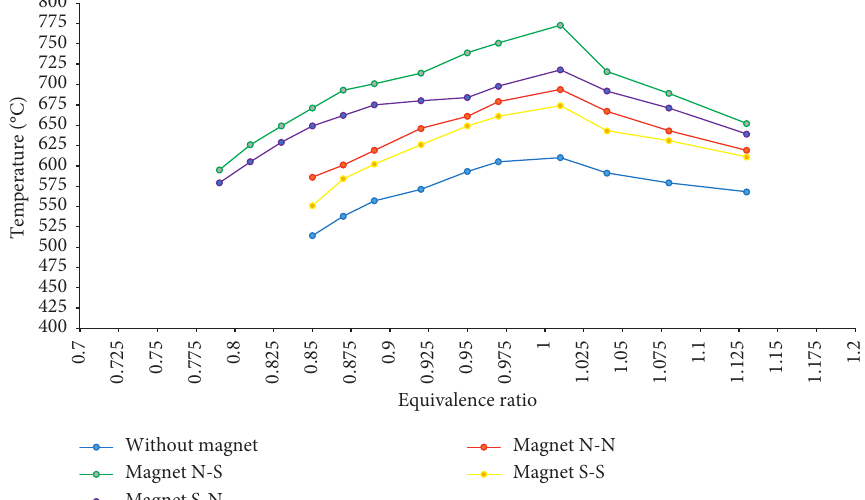
Figure 9: Flame temperature of jatropha oil versus equivalence ratio at various magnetic field orientation and without magnetic field.